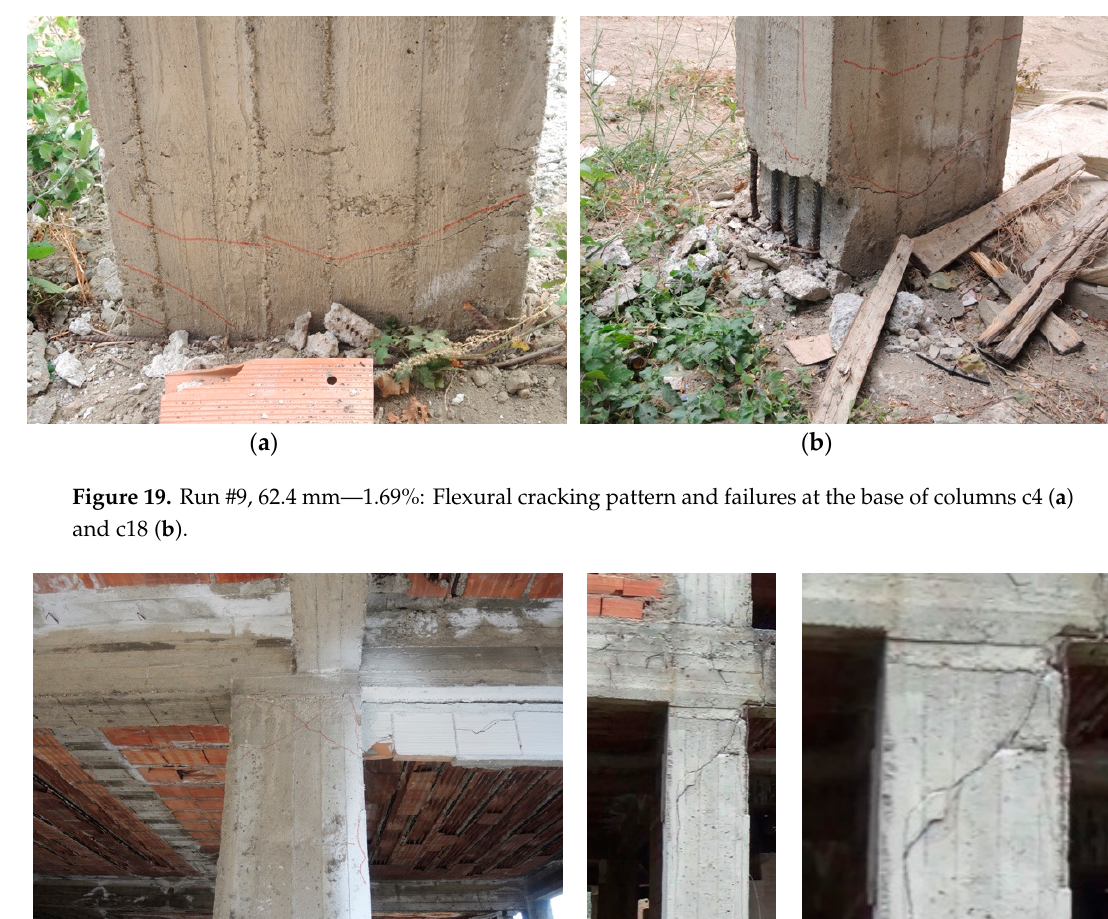
Figure 18. Run #9, 62.4 mm—1.69%: Damage at the top ( a ) and at the base ( b ) of column c11.